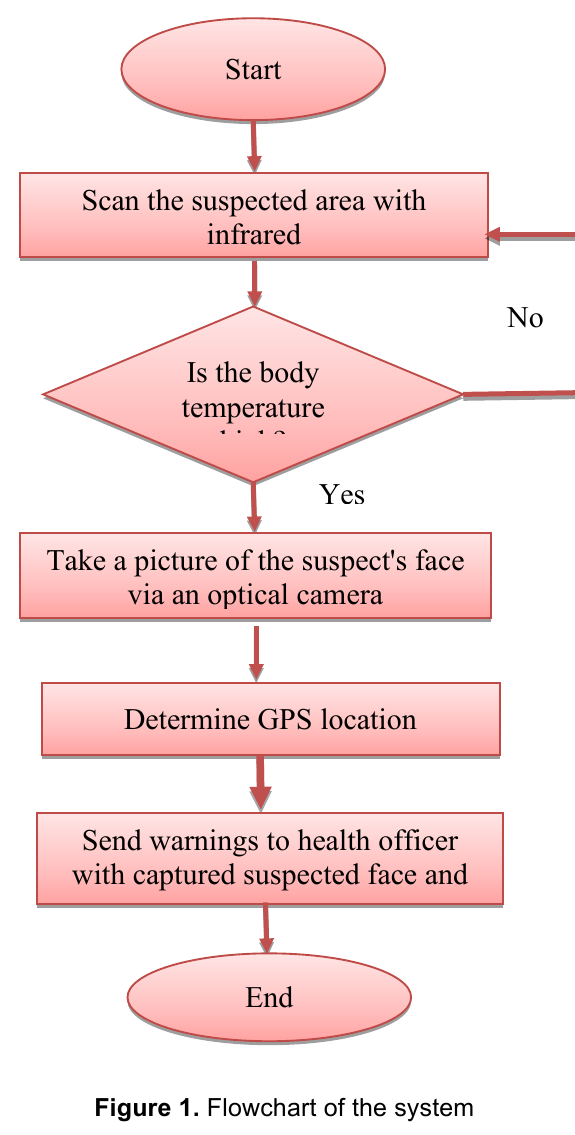
Figure 1. Flowchart of the